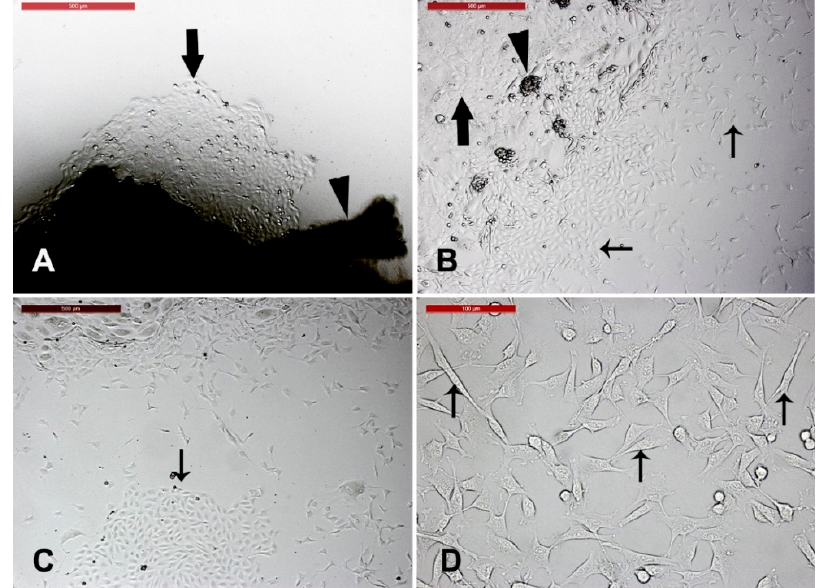
Figure 1. Camel skin explants and outgrowths at P0 (passage zero). ( A ) Camel skin explant (arrowhead) with early outgrowth of monolayer of keratinocytes (black arrow) on day 10 of explant seeding. ( B , C ) Additional growth of keratinocytes (black arrow) and migration and appearance of cell clumps (arrowhead; later characterized as spheroid progenitors) fibroblast either scattered or in colony (thin arrows). Scale bars = 200 µ m. ( D ) A magnified image of the fibroblast (thin arrows). Scale bar = 100 µ m. All cultures were performed in 35 mm tissue culture dishes and maintained in the same conditions in humidified atmosphere at 38 °C under 5% CO 2 .